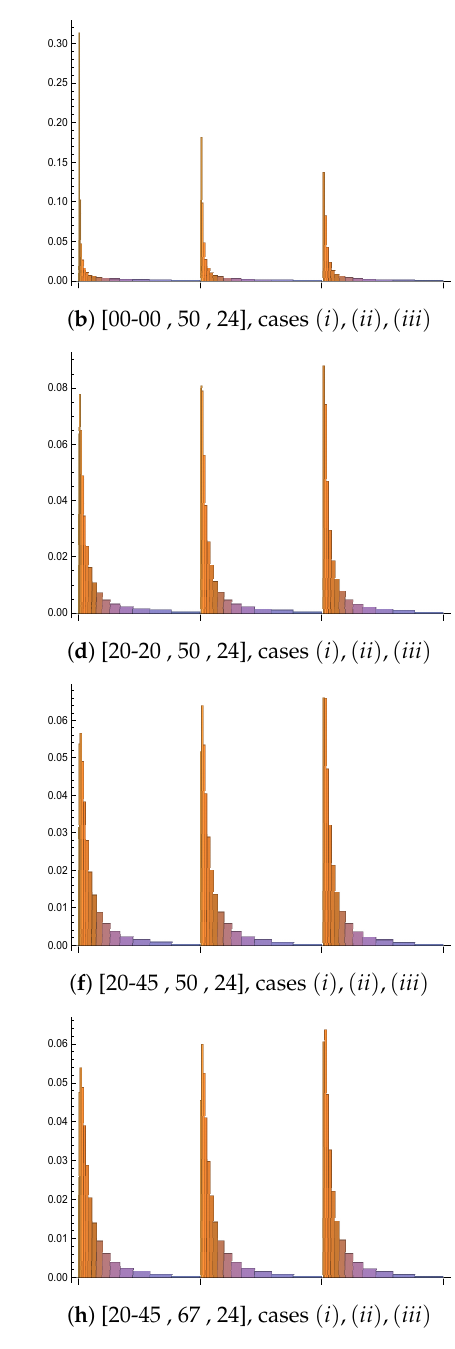
Figure 2. The three histograms in each of the panels ( a – h ) show the long-run stationary distribution relative to the cases ( i ) , ( ii ) , ( iii ) of the model quoted in the relative caption. One may notice here the different width of the income intervals defining the income